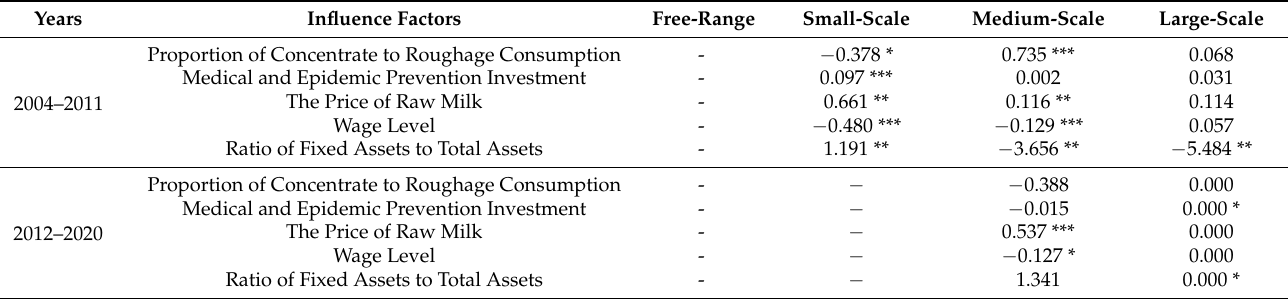
Table 12. Results of influencing factors of grouping regression efficiency.